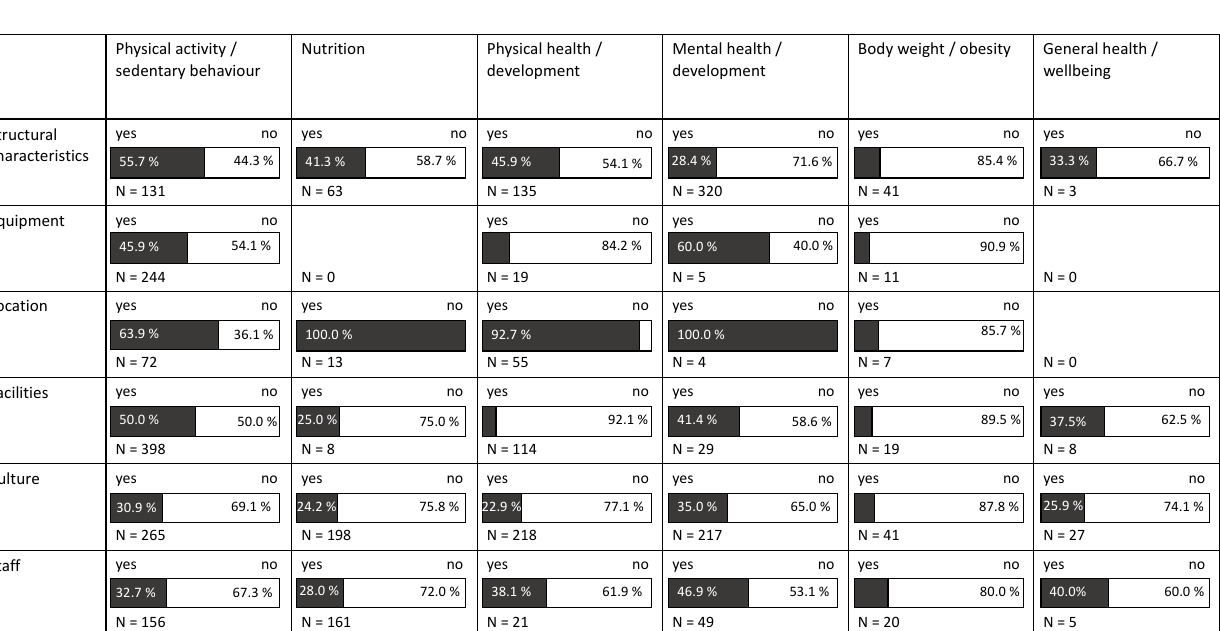
Figure 4. Associations between ECEC center MLCs with health, health behavior, and wellbeing of children.